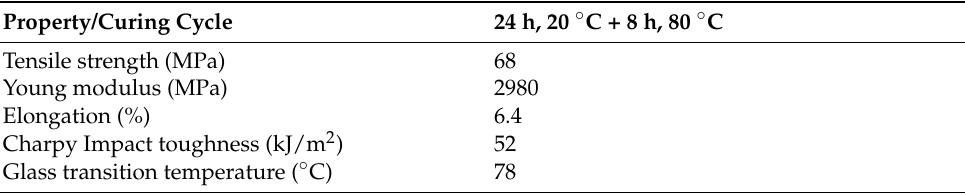
Table 1. Properties of plant-based epoxy SR GreenPoxy 56/SD 7561 after 8 h of post-curing at 80 ◦ C. Property/Curing